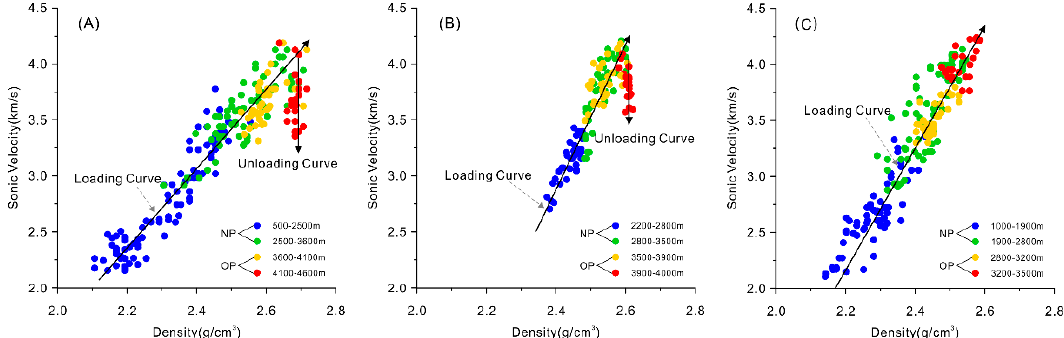
Figure 10. Acoustic velocity–density crossplots for well ( A ) X99, ( B ) X381, and ( C ) X960 in the Linnan Sag. Points remain on or near the loading curve, indicating disequilibrium compaction, while the overpressured data lie on an unloading curve, suggesting that the overpressure is generated by fluid expansion or transfer processes. NP = normal pressure, OP = overpressure. The well locations are shown in Figure 1C.